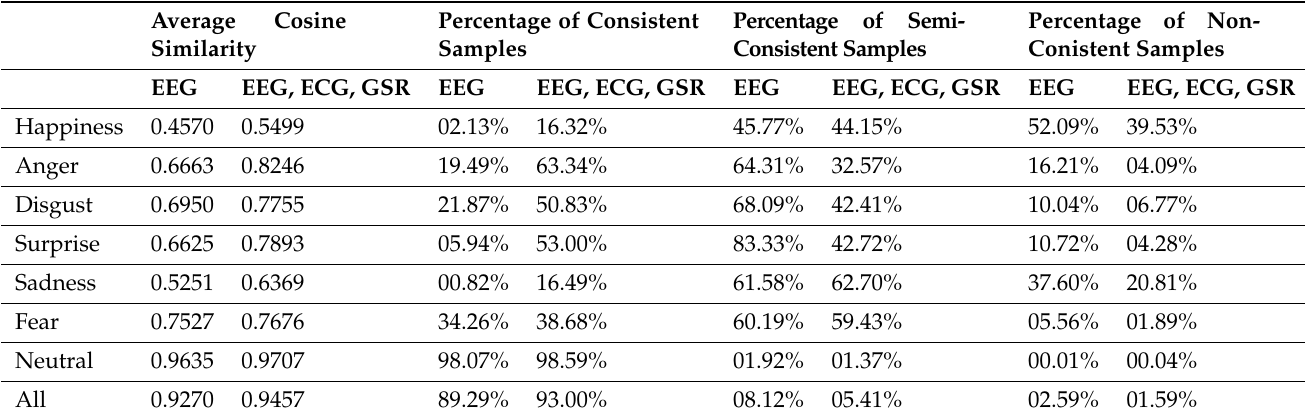
Table 11. Analysis of cosine similarity for Experiments 3 and 4.